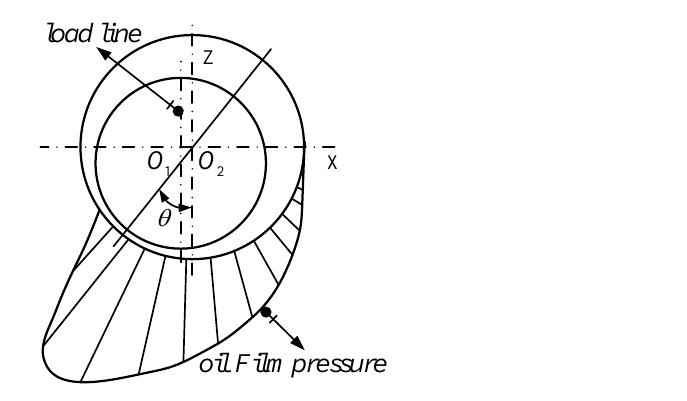
Figure 10. Variations of  with the wave phase angle under four cases.